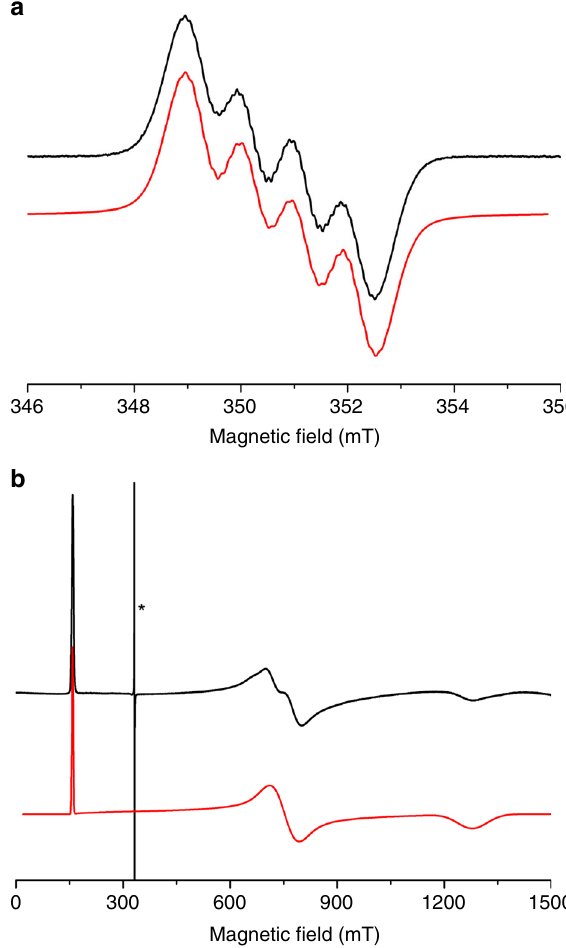
Fig. 4 EPR data for 5 and 6. a X-band (9.8 GHz) EPR spectrum of 5 at 298 K as a 9 mM solution in THF. The black line is the experimental spectrum and the red line the simulation with g = 2.003, A ( 11 B) = 9.44 G, A ( 10 B) = 2.7 G, A ( 1 H) = 1.2 – 1.4 G. b X-band (9.3 GHz) EPR spectrum of a powdered sample of 6 at 20 K. The black line is the experimental spectrum and the red line the simulation with g = 4.19, 0.88, and 0.52. The very sharp signal marked with asterisk is a very small quantity of radical impurity with g = 2.